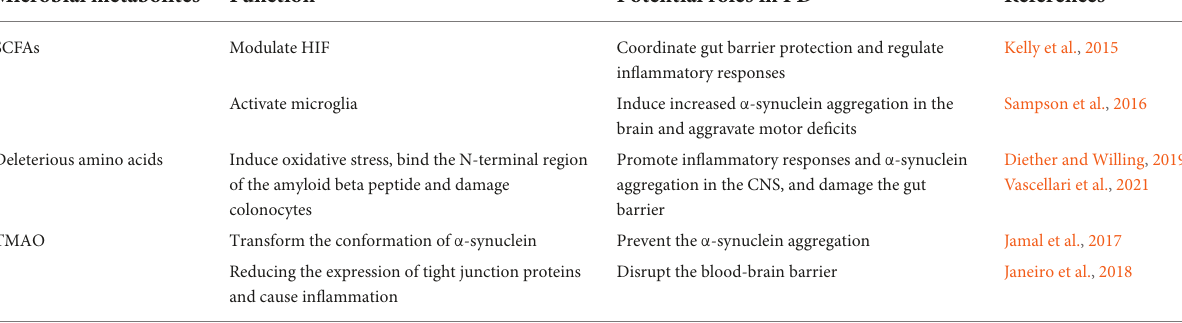
TABLE 2 Potential roles of microbial metabolites in